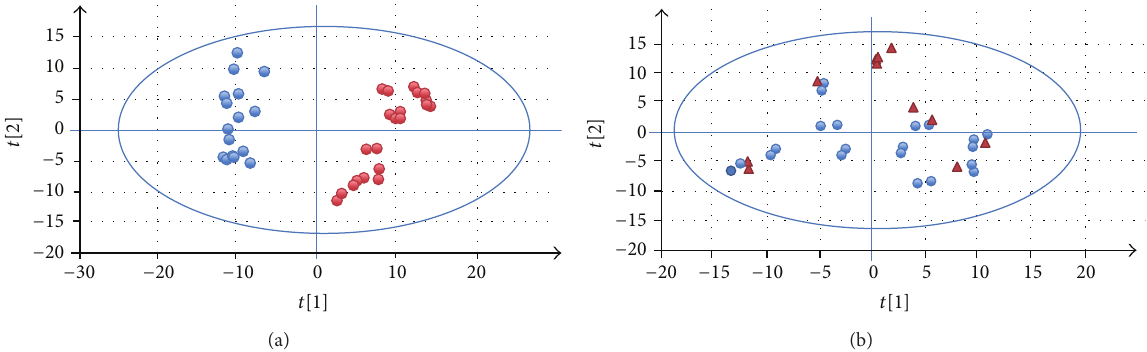
Figure 1: Score plot of PCA. (a) Blue circles represent healthy controls and red dots represent FSGS patient samples. (b) Blue dots represent FSGS patient samples and red triangles represent IgAN patient samples. Each of the samples was analyzed with two technical replicates.